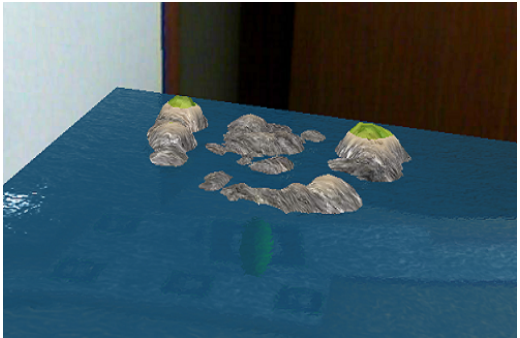
Fig. 12. Complex terrain generated using multiple volume functions.